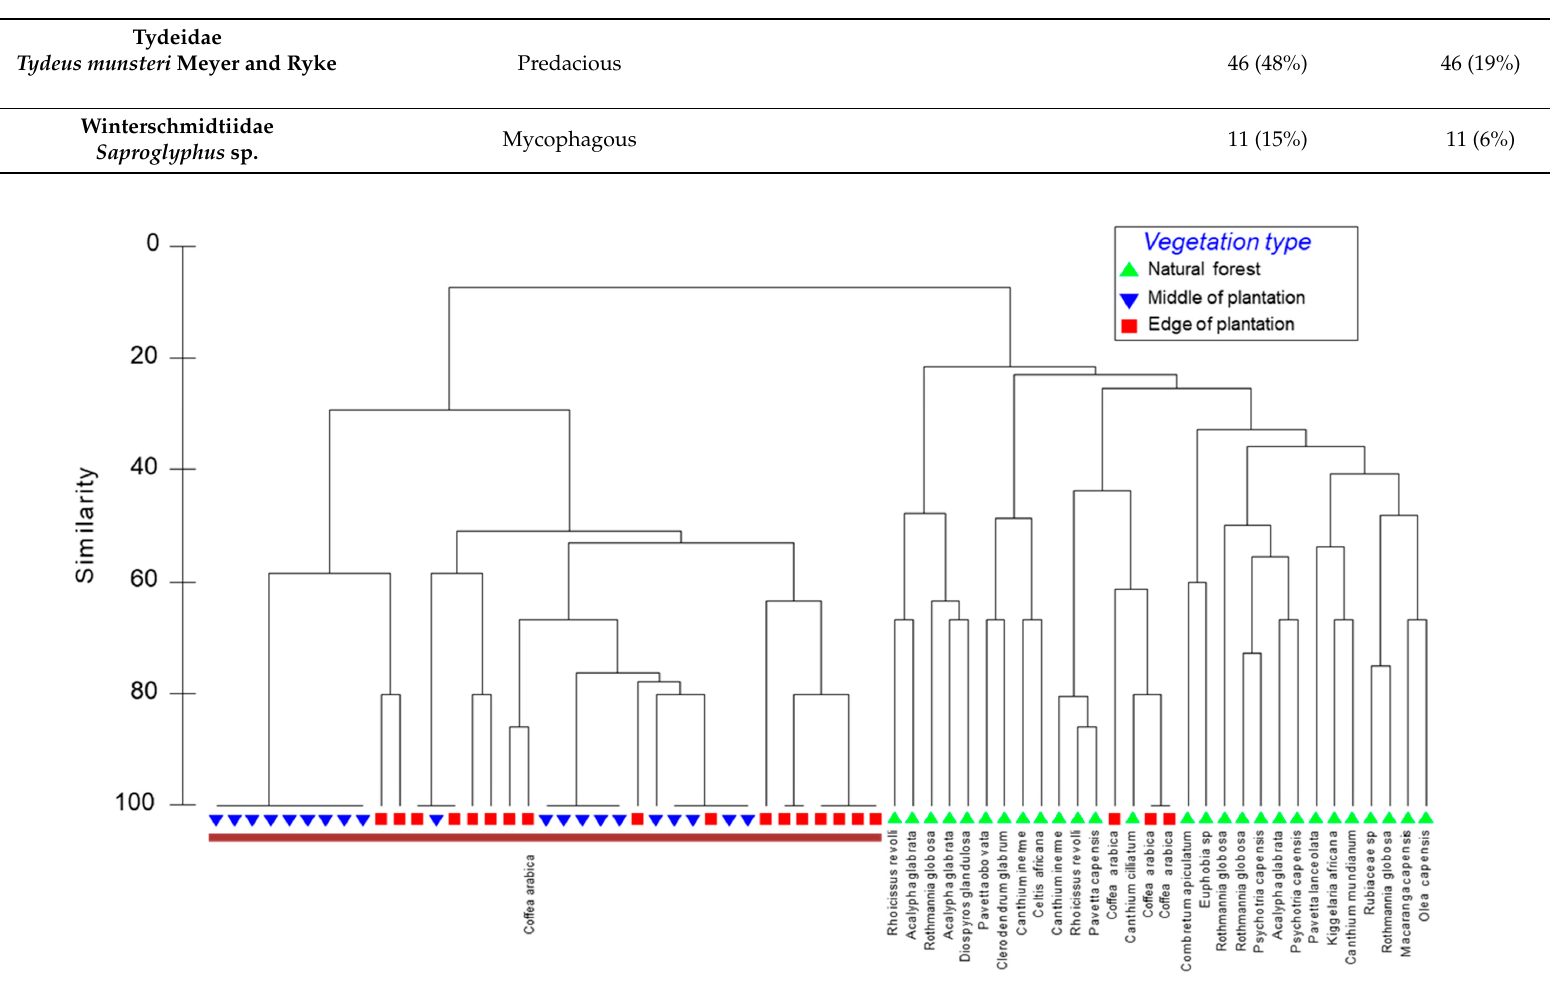
Figure 2. A group average dendrogram produced by using the Bray–Curtis similarity measure, showing similarities between coffee sample sites and the different indigenous plant species sampled from the adjacent forest.